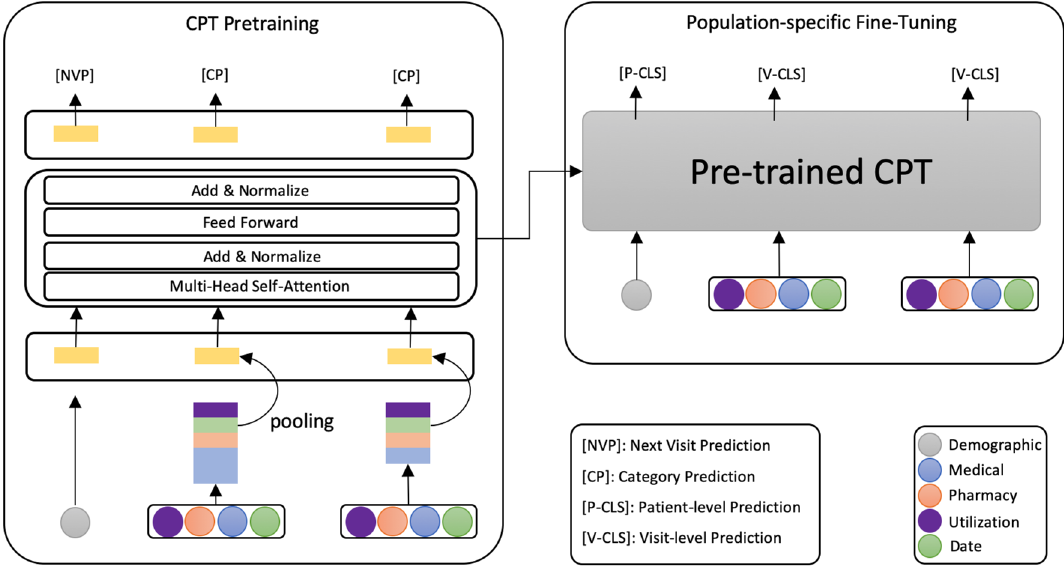
Figure 2. The overview of our pre-training and fine-tuning